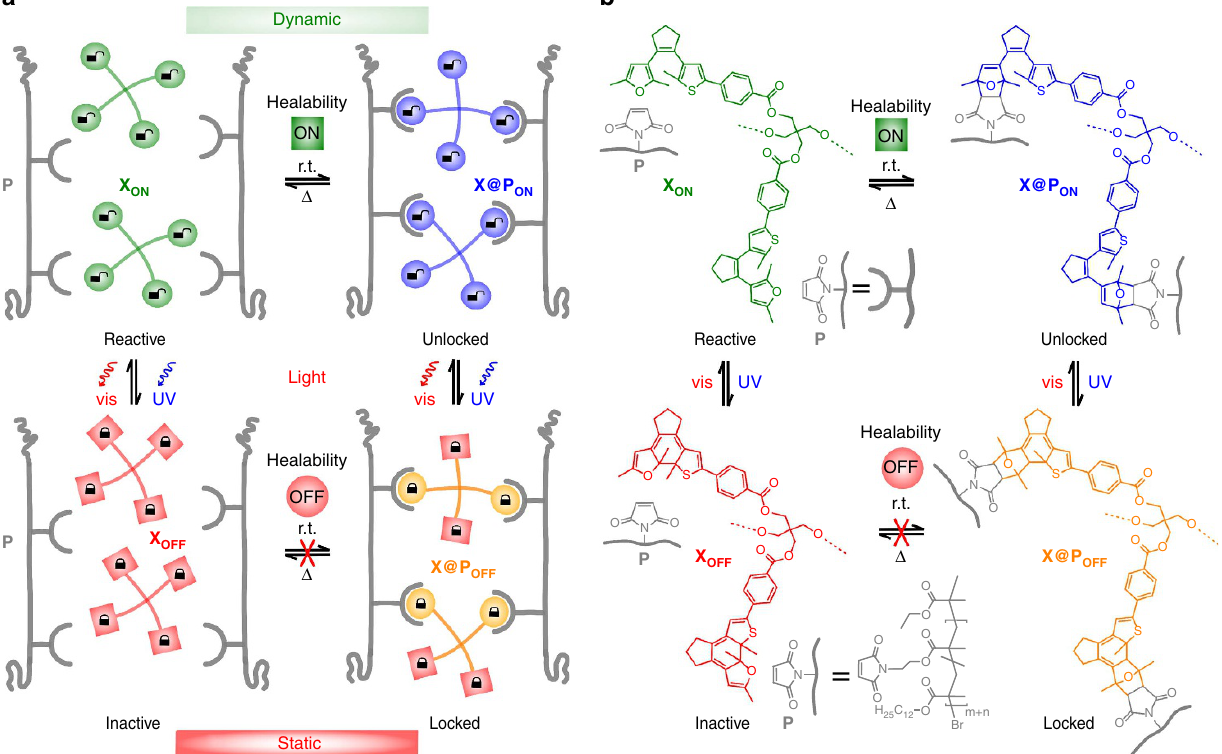
Figure 1 | Switching the thermal healability of dynamic polymer networks by light. ( a ) Schematic representation of a photoswitchable crosslinker X ON in its reactive state and polymer P carrying complementary reactive groups forming the dynamic covalent polymer network X@P ON , which can be de- crosslinked on heating. On illumination with ultraviolet-light the crosslinker X as well as the polymer network X@P are reversibly transformed into their inactive state ( X OFF and X@P OFF , respectively), where both crosslinking as well as de-crosslinking are inhibited. ( b ) Chemical structures of the tetrafuryl- substituted diarylethene crosslinker, which in its activated form X ON reacts with maleimide-functionalized poly(lauryl methacrylates) via the Diels–Alder reaction (for simplicity only two of four crosslinking units are shown). On heating the network is de-crosslinked due to the retro Diels–Alder reaction. Illumination with ultraviolet-light induces 6 p -electrocyclization to the ring-closed isomers of the deactivated crosslinker X OFF and the polymer X@P OFF , respectively. This process can be reversed and the crosslinker as well as the network can be activated by illumination with visible